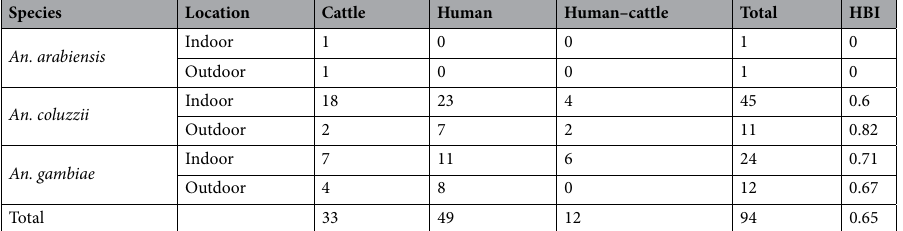
Table 3. Total numbers of blood-fed female An. gambiae s.l. caught using Resting Bucket Traps (RBT) in the 12 villages, from October 2016 to December 2018. Results are displayed by species, trapping location (Indoor or outdoors) and host blood source, pooled over village. ‘HBI’ indicate the ‘Human Blood Index’; estimated as the proportion of blood meals taken from humans out of the blood meals whose source could be identified. HBI indicate the proportion of mosquito that blood-fed on human.